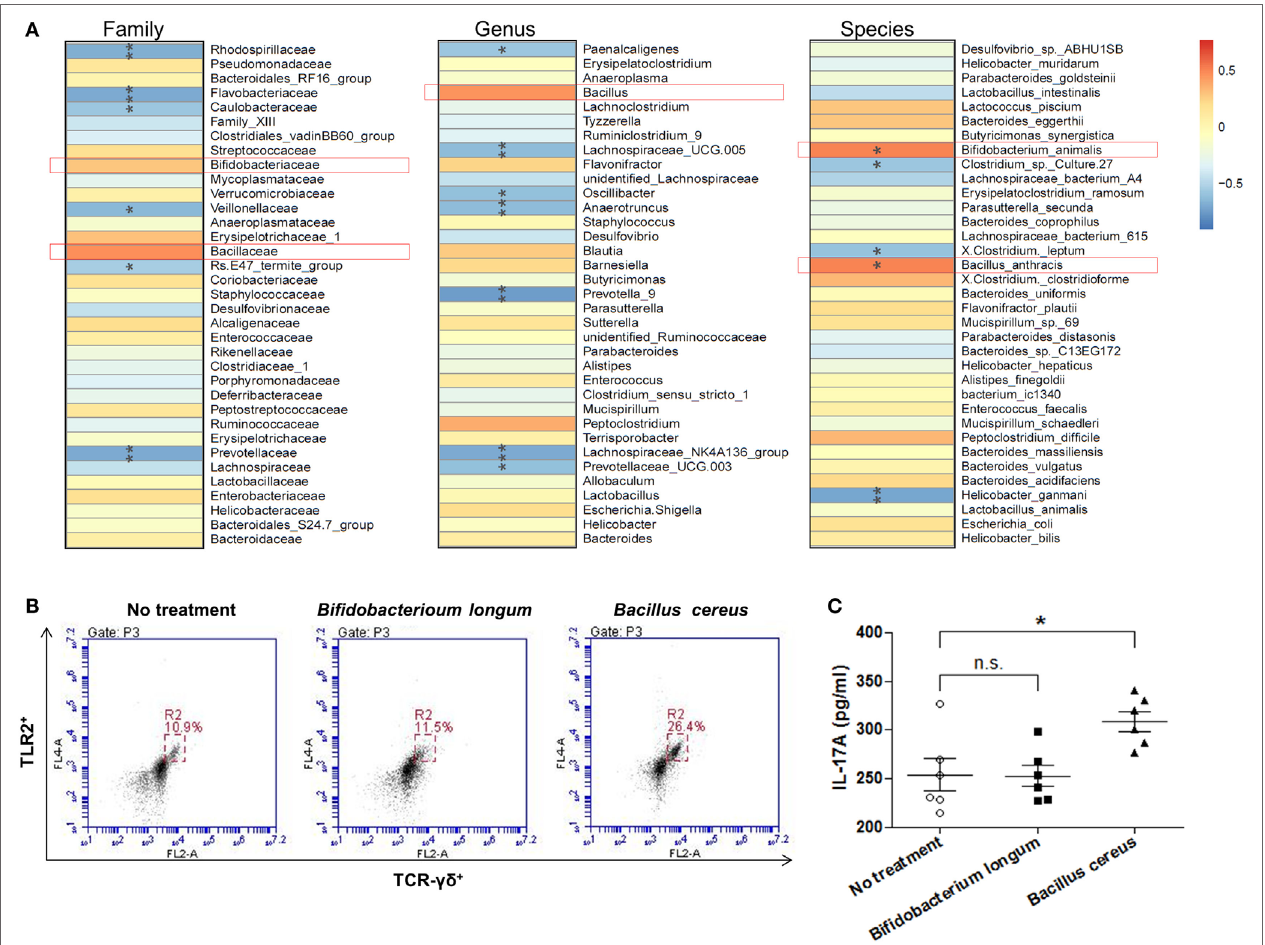
FigUre 7 | The correlation between intestinal bacterial groups and γδ T cells. (a) The correlation between the relative abundance of different microbial groups at family, genus, and species level and the population of γδ T17 cells was tested by Spearman correlation method. The positive correlation was displayed as correlation value > 0, and the negative correlation was displayed as correlation value < 0; statistically significant correlation was displayed as * p < 0.05; ** p < 0.01. (B) Flow cytometry analysis of TLR2 expressing γδ T cells among purified splenic γδ T cells treated or un-treated with specific bacterial strain. (c) IL-17A concentration in supernatant from purified splenic γδ T cells treated or un-treated with specific bacterial strain in vitro detected by ELISA. All values are mean ± SEM ( n = 5). The non-parametric t -test was performed between two groups by the assistant of GraphPad Prism 5. * p < 0.05, n.s., not